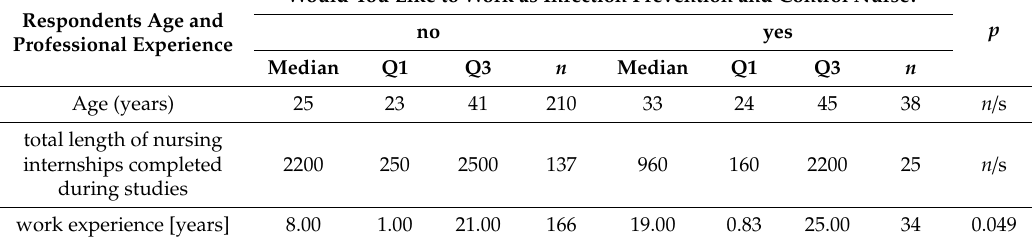
Table 2. Respondents’ declaration of willingness to work as an infection control nurse depending on age, practical training, and work